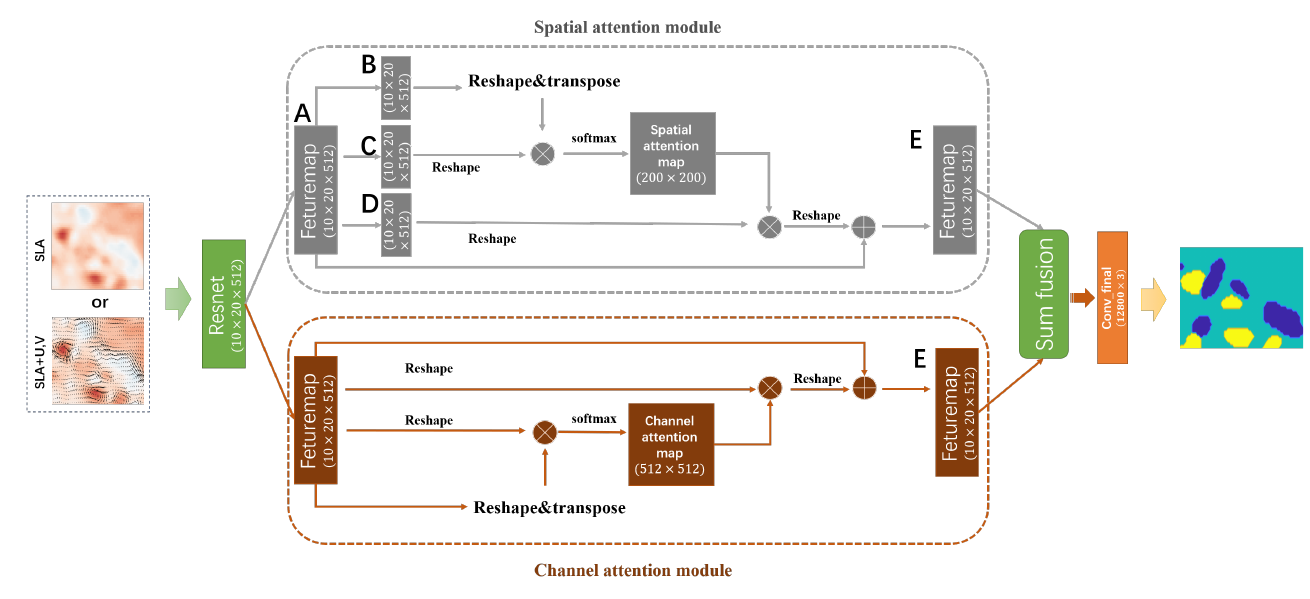
Figure 2. Schematic diagram of the Dual Attention Network